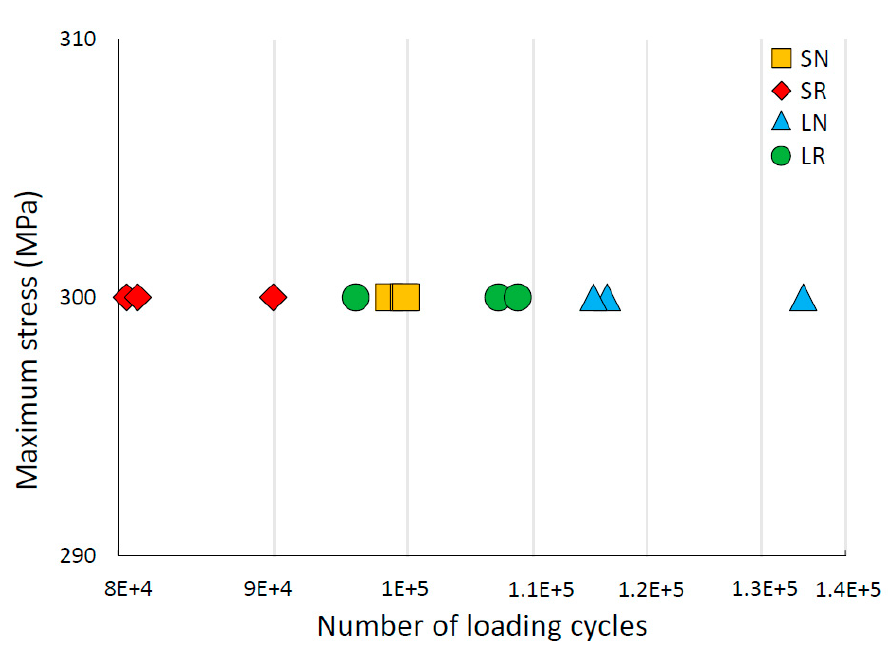
Figure 7. Fatigue results at the logarithmic scale of the LPBF Ti-6Al-4V specimens: small diameter and new powder (SN), small diameter and recycled powder (SR), large diameter and new powder (LN), and large diameter and recycled powder (LR).